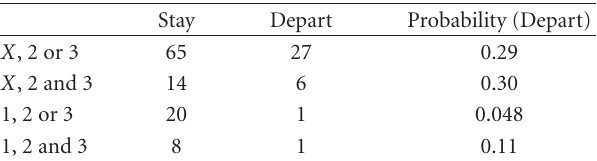
Table 8: Departure patterns of bumble bees on treated inflores- cences of Aconitum columbianum . Control treatment with zero microliters of 30% sucrose solution in bottom flowers of the inflorescence, and zero in second-from-bottom flowers (2), and zero in third-from-bottom flowers (3). The notation in this and Table 9 is X , 2 or 3 stands for bees that began by visiting the empty second or third flower first, without visiting the bottom flower. X , 2 and 3 stands for bees visiting both empty flowers first. 1, 2, or 3 stands for visiting the treated bottom flower and then the empty second or empty third flower. 1, 2 and 3 stands for visiting the treated bottom flower and then both the empty second and empty third flowers.